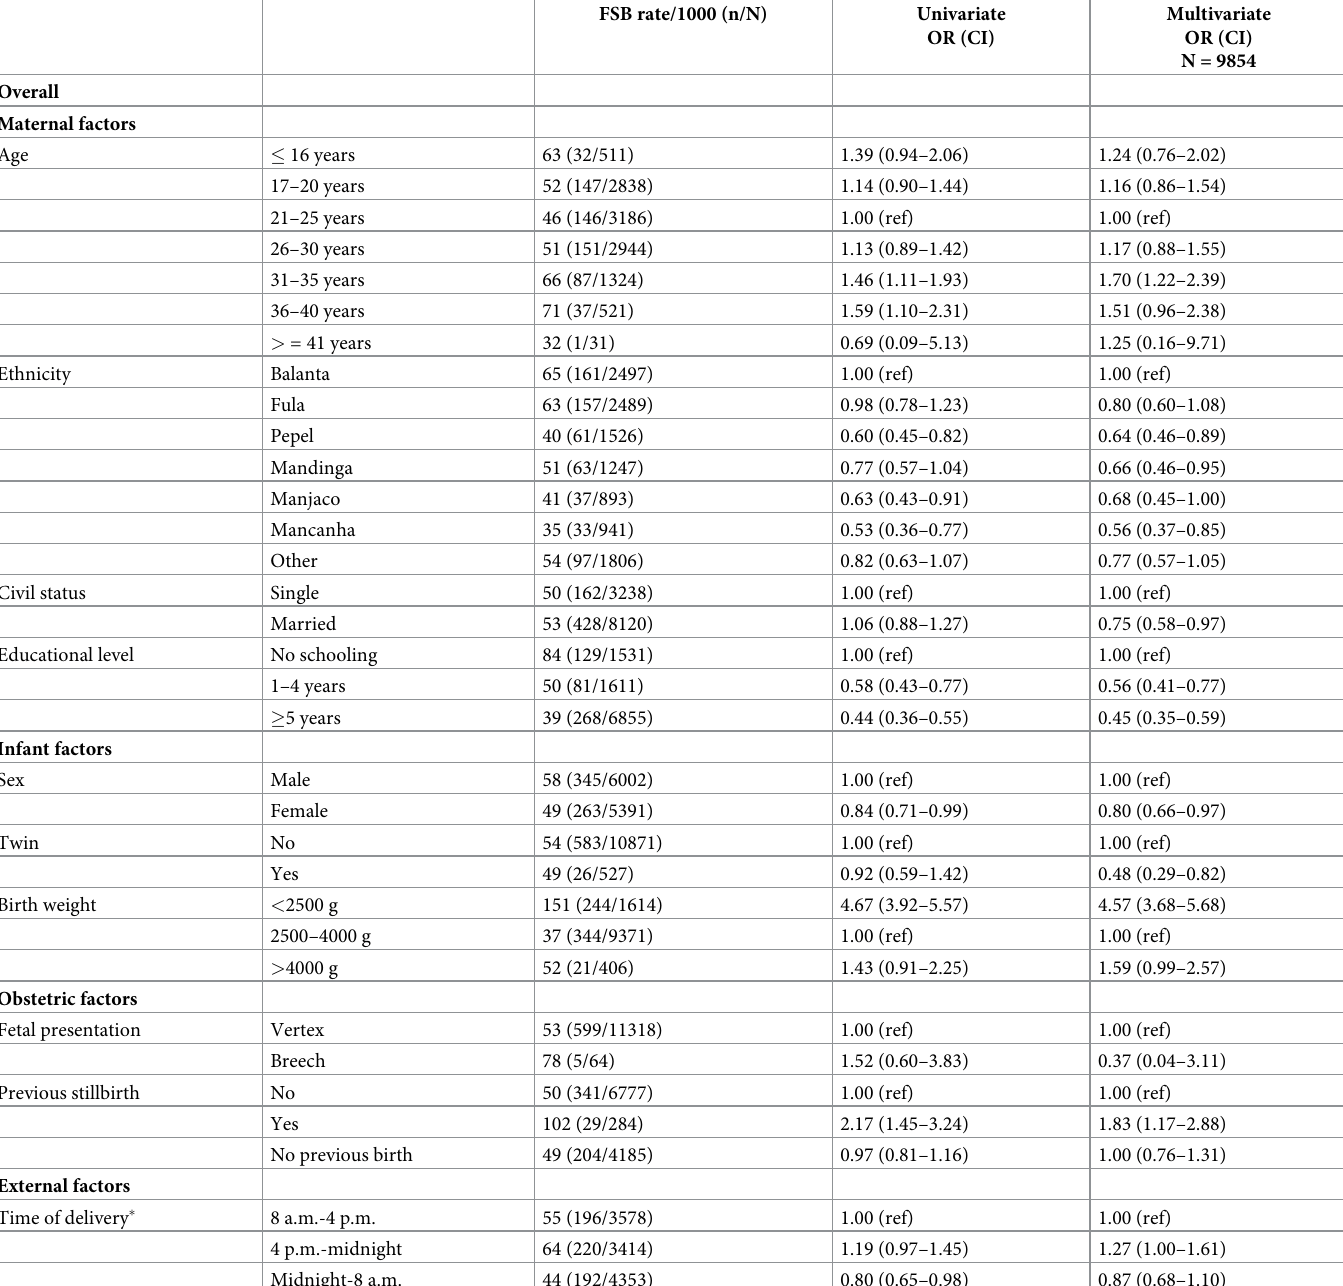
Table 3. Risk factors of fresh stillbirth (FSB) at the HNSM hospital. Women from outside Bissau city